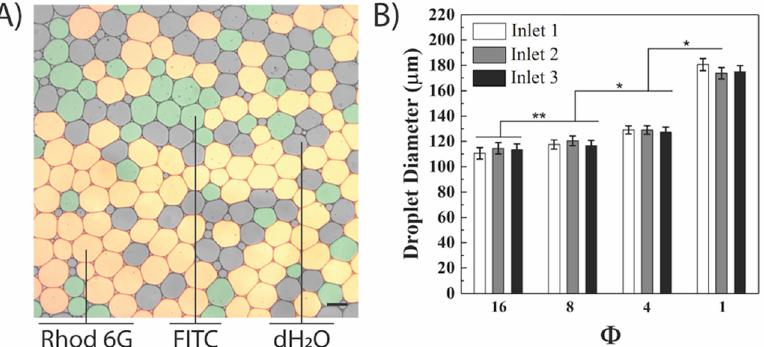
Figure 4. Decreasing the oil-to-water ratio ( Φ ) increased droplet diameter in gravity-driven flow. ( A ) Overlay fluorescence microscopy image of the droplets generated from inlets 1 (dH 2 O), 2 (FITC), and 3 (Rhodamine 6G) at Φ = 16. Scale bar represents 100 µ m; ( B ) the mean droplet diameter from the three different inlets at the same oil-to-water ratio were not significantly different from each other at a given Φ . However, the cumulative inlet averages across different Φ values were statistically different with * denoting p > 0.05, ** denoting p > 0.01 thresholds. For each inlet, 30 droplets were measured, and the results are representative of a single trial.